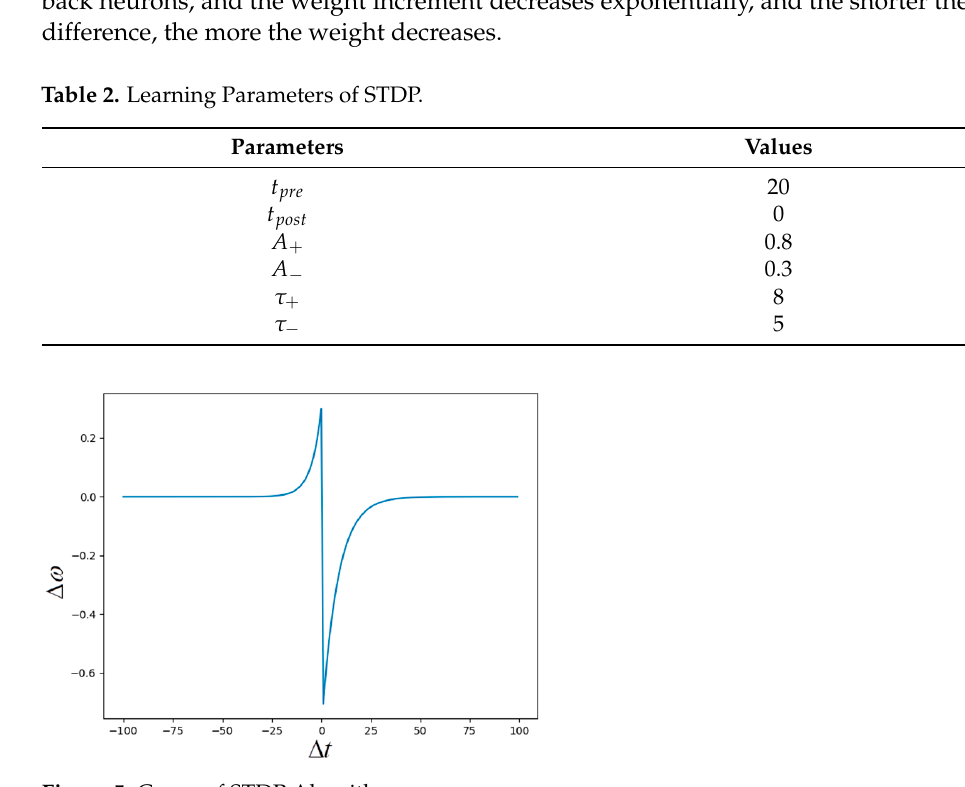
Table 2. Learning Parameters of STDP.